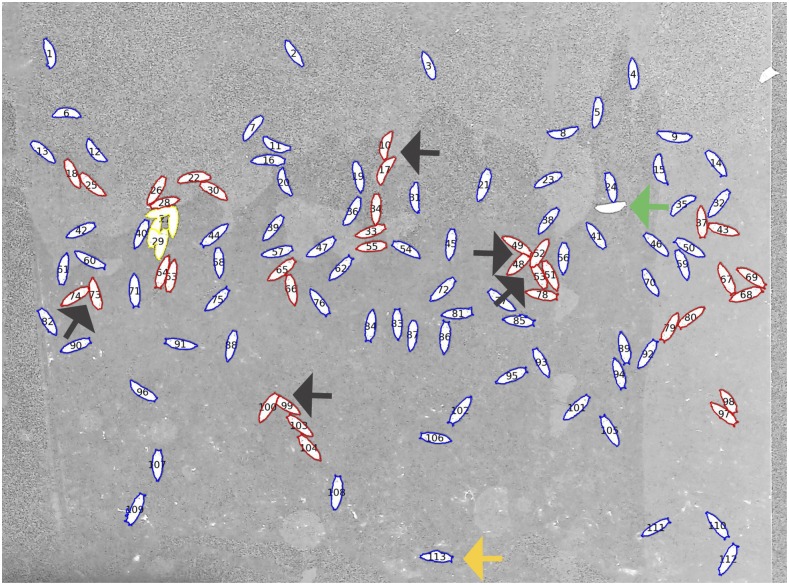
Visual output of automated phenotyping system. Blue outline = high confidence pupae, red outline = medium confidence pupae, and yellow outline = low quality objects. A small proportion of pupae are entirely missed by the automated system (green arrow). Others are aberrantly measured due to close proximity to other pupae resulting in truncation or extension of their outline. Even those with a high confidence assignment can also appear malformed (orange arrow). They should be manually excluded from analysis to reduce noise (see File S1 for more examples of aberrant and canonical pupae). All objects are numbered in Cellprofiler output files to permit numerical measurements to be easily related to images.